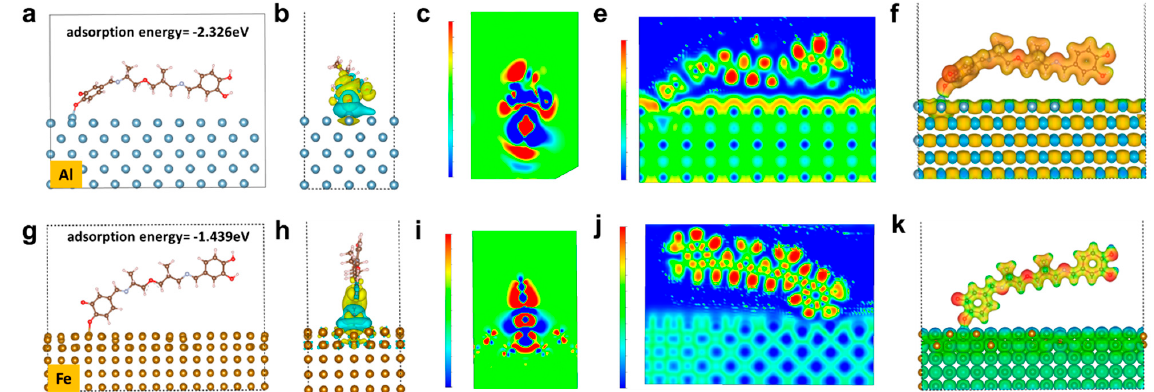
Figure 5. Electronic property and adsorption energy for ( a ) Al and ( g ) Fe; charge density for organic molecule adsorbed on ( b ) Al and ( h ) Fe; cross-sectional analysis of charge density for organic molecule adsorbed on ( c ) Al and ( i ) Fe; electron localization function for organic molecule adsorbed on ( e ) Al and ( j ) Fe; electrostatic potential distribution for organic molecule adsorbed on ( f ) Al and ( k ) Fe.